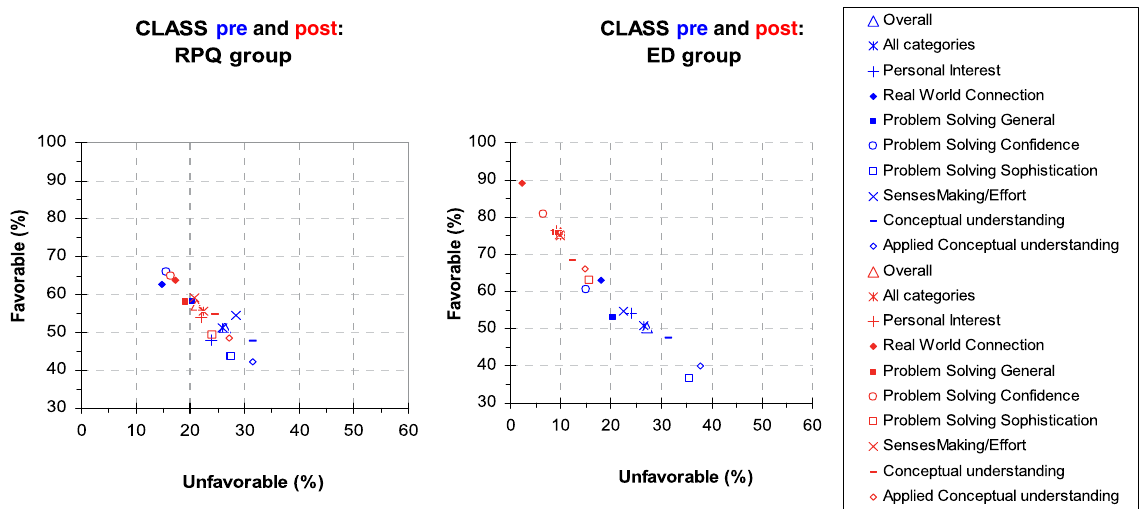
FIG. 2 (color online). Overall scores and scores ‘‘personal’’ by category on pre-CLASS and post-CLASS test for RPQ group and ED